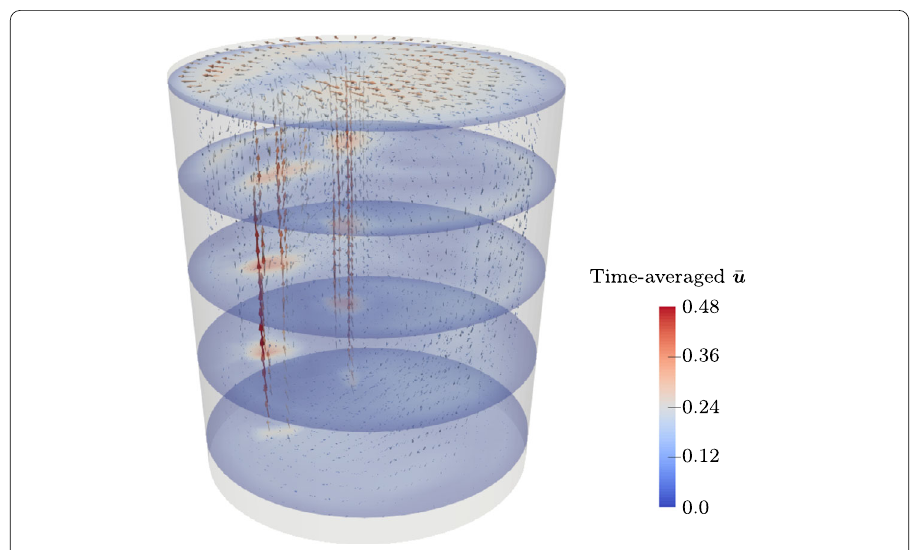
Figure 4 Optimization of gas flow rates. Subdomain (cid:2) 0 in the objective functional J 2 for the optimization of Q i , i ∈ { 1,2 } . It covers the region where the dead zones are more likely to appear, i.e., the lower half of , excluding the area of the plume the domain z ≤ H 2 cones defined as a box (–0.175 ≤ x ≤ –0.05 and –0.175 ≤ y ≤ 0.175). This choice is suitable to